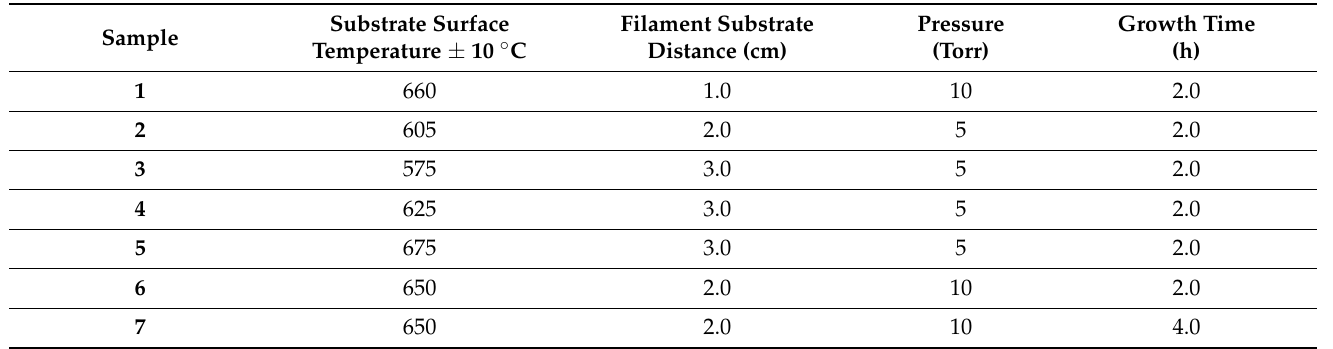
Table 1. Number of NG/Cu anodes (Samples) prepared, substrates’ surface temperature, filaments- substrates’ distance, chamber pressure and growth time.